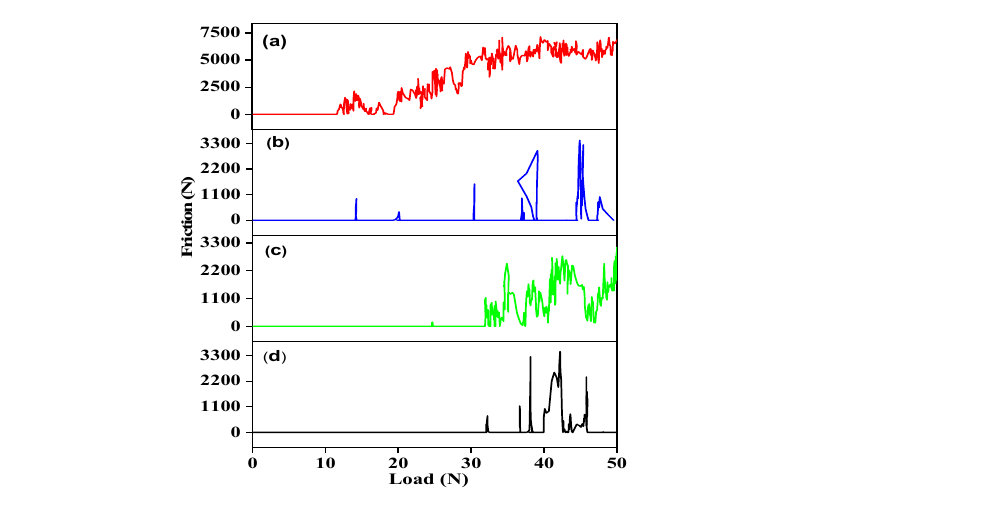
Figure 15. Shows the adhesion strength test curves measured by the scratch tester: ( a ) Ni-W(P), ( b ) Ni-W(GP), ( c ) Ni-W/6SiC(P) and ( d )